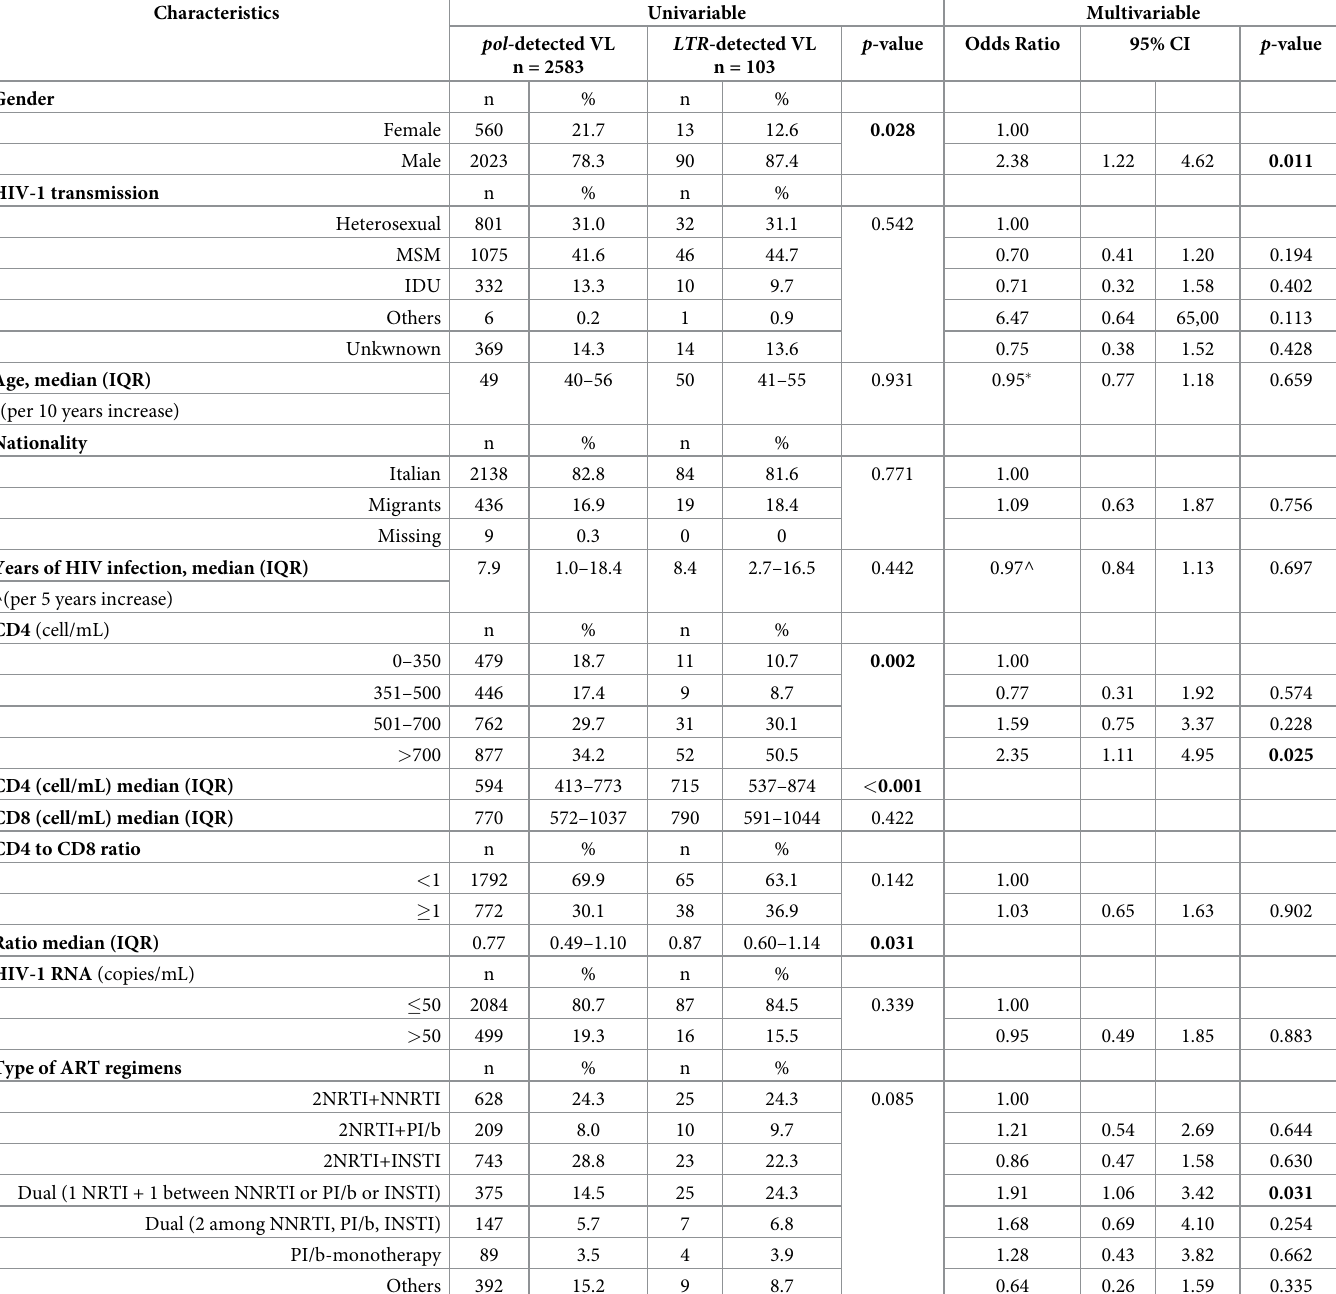
Table 2. Comparison of demographic-viro-immunological characteristics observed in patients with VL detected with pol or LTR regions by Aptima and logistic regression model of factors associated with VL detected with LTR region, but not with pol .